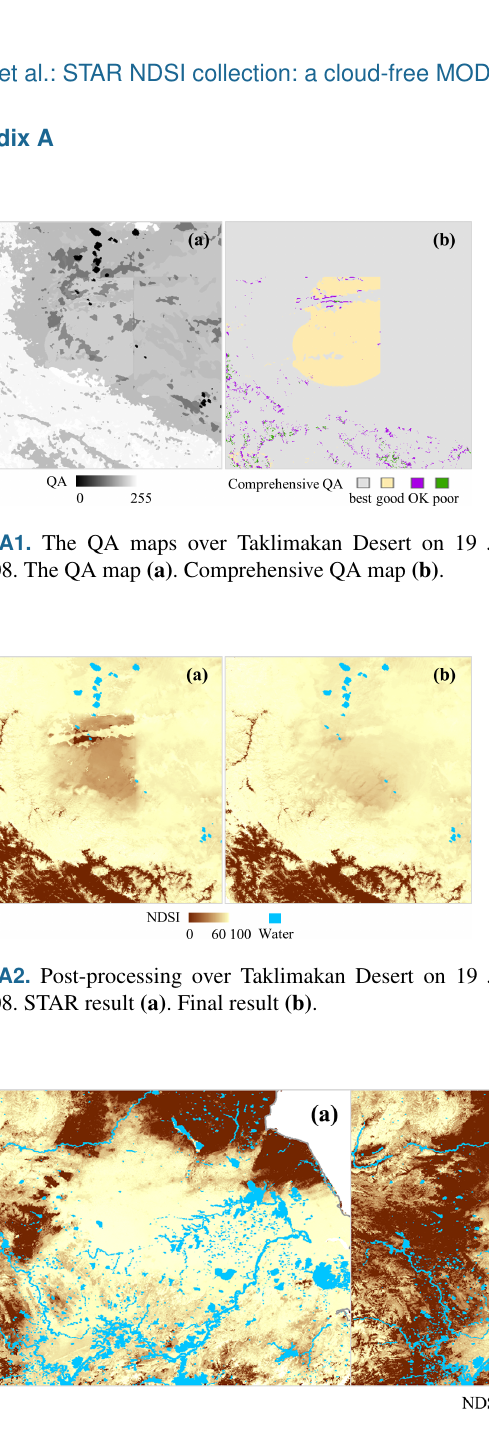
Figure A3. Extreme snow event in southern China on 31 January 2008 (a) , 5 February 2008 (b) , and 10 February 2008 (c)